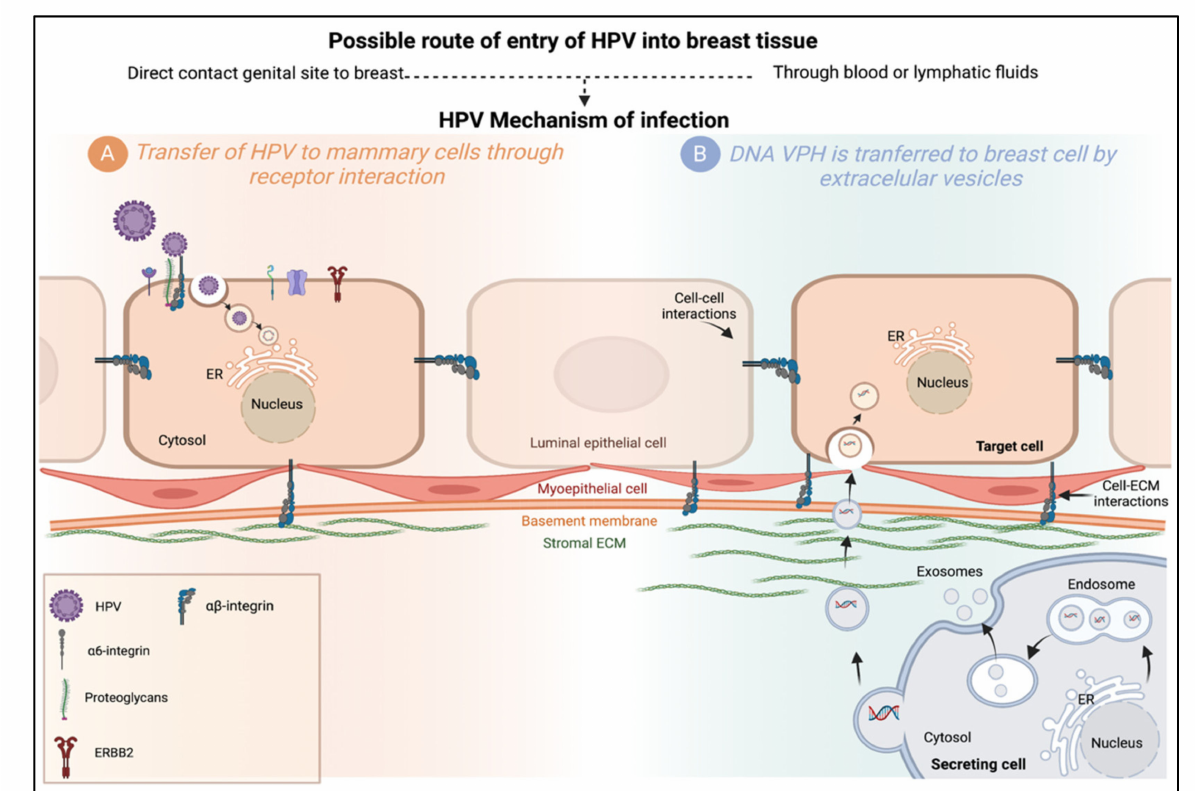
Figure 3. Possible mechanisms of HPV infection in the mammary gland. ( A ) Transfer of HPV to mammary cells through receptor interaction. The HPV-16 capsid interacts with the entry receptor complex composed of growth factor receptors, integrins, and proteoglycans, among others. After HPV binds to this complex, an endocytic process begins. Internalized viruses reside in vesicles directed to acidified multivesicular bodies for capsid disassembly. Viral genomes are transported to the TGN, ER, or core. ( B ) DNA HPV is transferred to breast cells by extracellular vesicles. Transfer of HPV DNA to cells lacking the HPV receptor could be carried out by extracellular vesicles (EVs), microvesicles (EVs), exosomes (Exos), or apoptotic bodies (ABs), which serve as vehicles for cell communication. Cell-to-cell, from a primary site of infection through the transfer of bioactive molecules (proteins, lipids, and nucleic acids). Extracellular vesicles produced from a secretory cell may be internalized by fusion, endocytosis, or phagocytosis, or interact with target cell membrane proteins. Created by